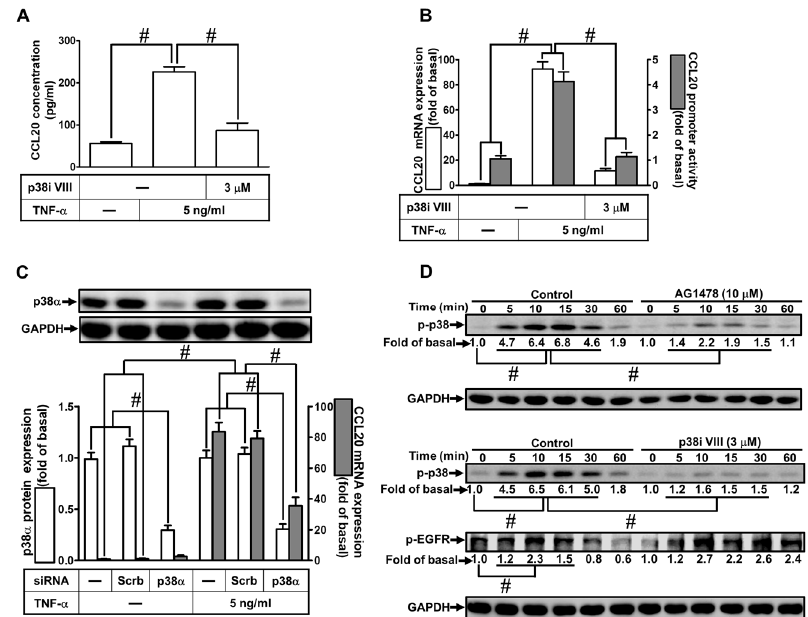
Figure 4. Involvement of p38 MAPK in TNF- α -induced CCL20 expression. ( A ) Cells were pretreated with 3 μ M p38 inhibitor Ⅷ (p38i Ⅷ ) for 1 h and then incubated with 5 ng/mL TNF- α for 12 h. The conditioned media were utilized to determine the CCL20 level via an ELISA kit. ( B ) Cells were pretreated with 3 μ M p38i Ⅷ for 1 h and then incubated with 5 ng/mL TNF- α for the indicated time. The mRNA levels and promoter activity of CCL20 were determined by real-time PCR (2 h) and promoter assay (4 h), respectively. ( C ) Cells were transfected with scrambled or p38 α siRNA and then incubated with TNF- α for 2 h. The mRNA levels of CCL20 were determined by real-time PCR. The protein levels of p38 α were determined by Western blot with GAPDH as a loading control. ( D ) Cells were pretreated without or with 10 μ M AG1478 or 3 μ M p38i Ⅷ for 1 h and then treated with TNF- α for the indicated times (0, 5, 10, 15, 30, and 60 min). The phosphorylation of p38 and EGFR was determined by Western blot with GAPDH as a loading control. Data are expressed as mean ± S.E.M. of three independent experiments ( n = 3). # p < 0.05, as compared with the cells exposed to vehicle alone; or significantly different as indicated.